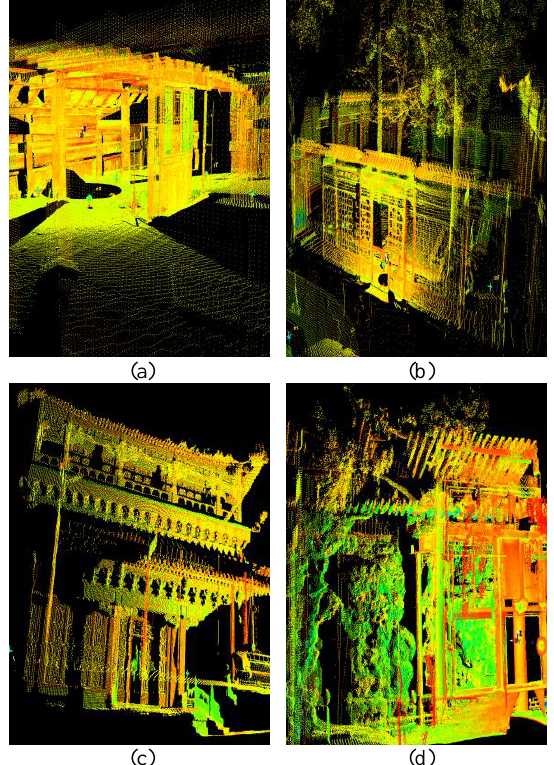
Figure 4. Point cloud of Qianlong Garden (a) Fuwangge; (b) Juanqinzai; (c) Yuzixuan; (d)